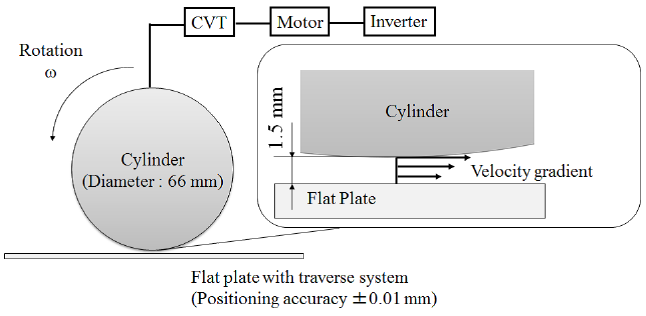
Fig. 6 Schematic view of the calibration test